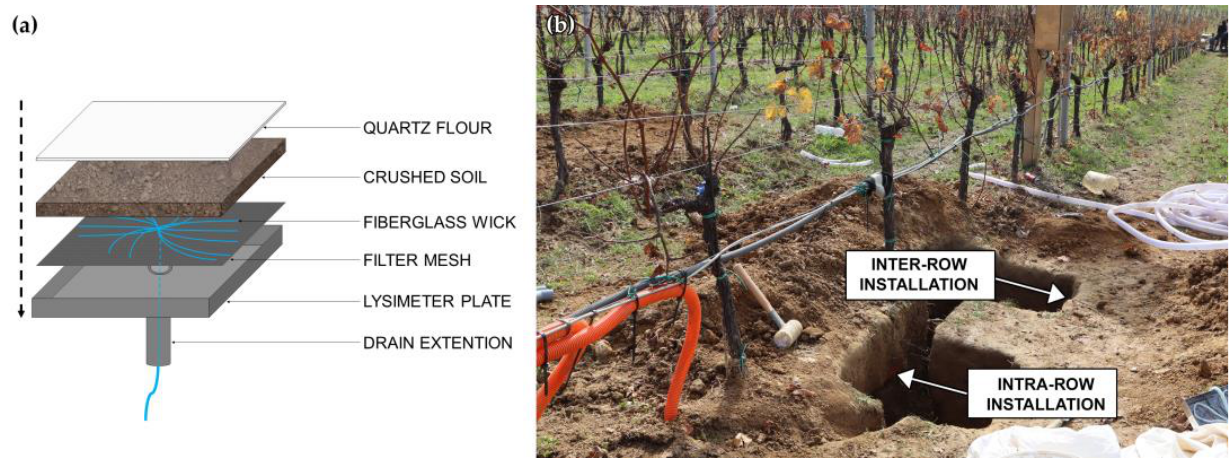
Figure 2. ( a ) Scheme of self-constructed passive wick lysimeters, and ( b ) installation of passive wick lysimeters.